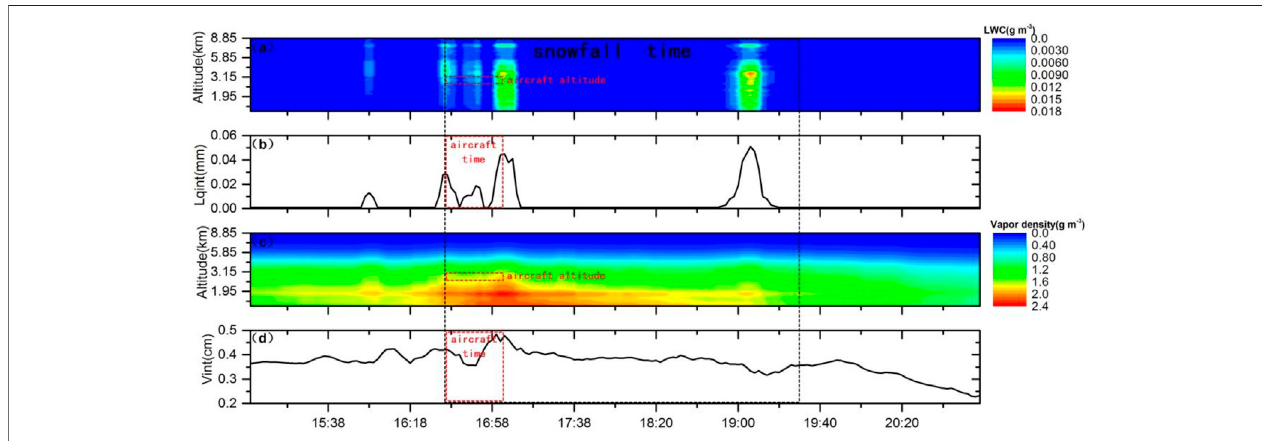
FIGURE6|(A) LWC(gm − 3 ), (B) LWP(mm), (C) Vapordensity(gm − 3 ),and (D) PWV(cm)observedbyRadiometerfrom1500BJTto2100BJTJan27,2021(black box: snowfall time, red box: aircraft close to Yanjiaping time at aircraft